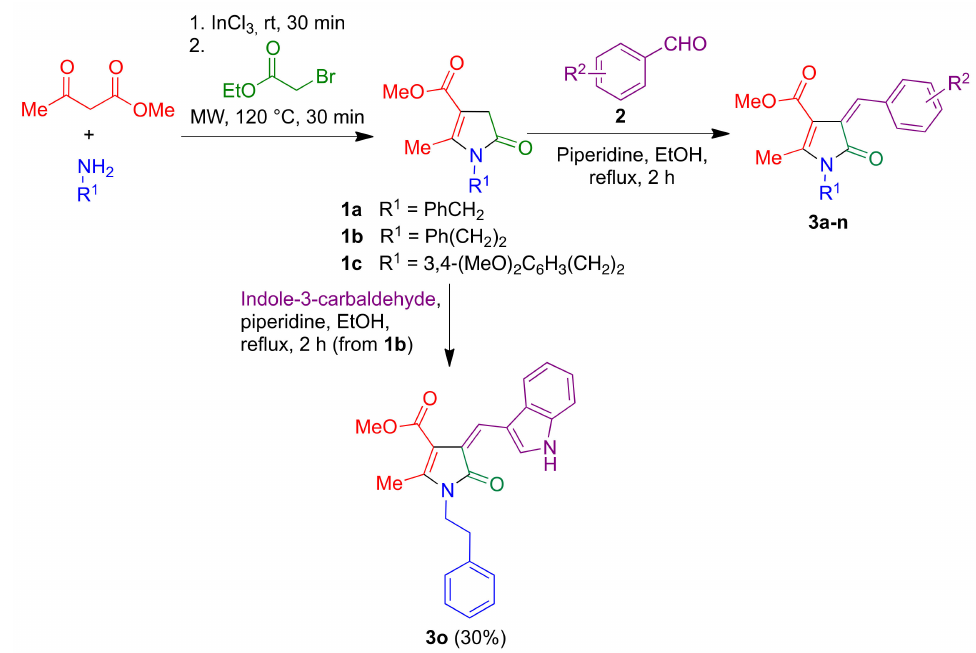
Figure 3. Synthesis of compounds 3